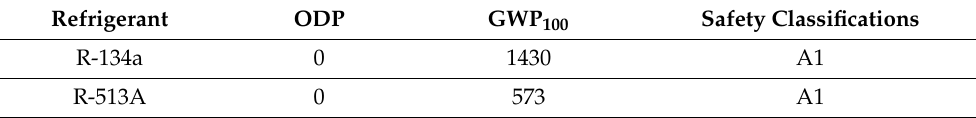
Table 2. Properties of R-134a refrigerant and R-513A refrigerant [23].